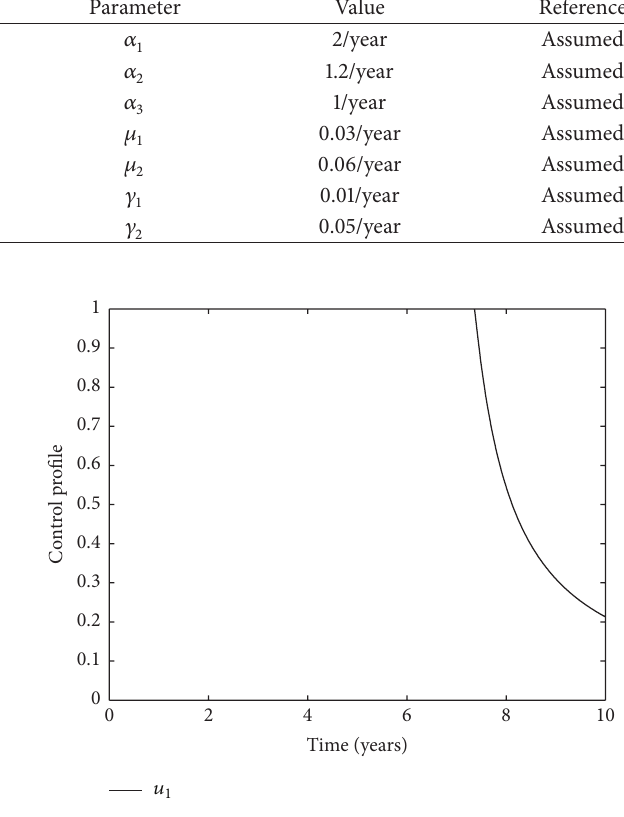
Figure 6: The profile of the optimal anti-TB control 𝑢 ∗ 1